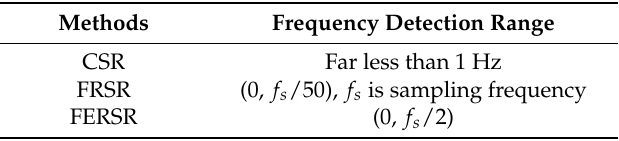
Table 2. The frequency detection ranges of different